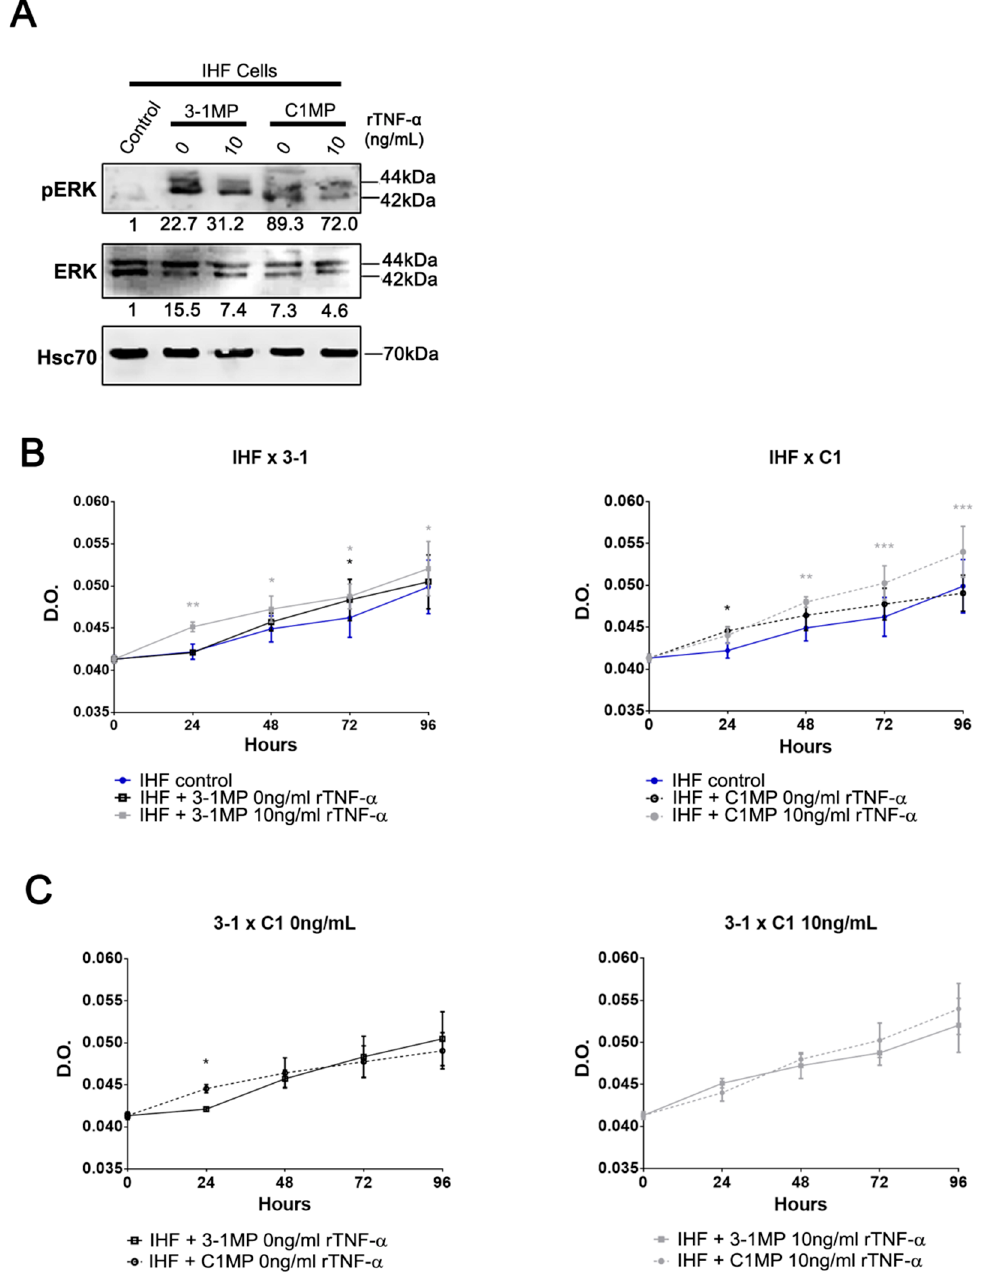
Figure 8. Proliferation rate of IHF cells after incubation with MP (microparticles) derived from parental and MDR cell lines. ( A ) Immunoblot analysis of ERK and phospho-ERK protein levels in IHF cells after incubation with MP derived from non-treated or 10 ng / mL rTNF- α treated KB-3-1 and KB-C1 cells. Western blot bands were quantified by densitometry. ( B , C ) Proliferation rate determined by crystal violet incorporation assay during 96 hour treatment with 3-1MP or C1MP derived from non-treated or 10ng / mL rTNF- α treated cells. Data are means ± SD of three independent experiments. Two-way ANOVA with Bonferroni posttest were used to analyze the crystal violet incorporation assay results. Black and gray asterisks represent statistical significance between MP derived from non-treated and rTNF- α -treated cells, respectively. * p < 0.05; ** p < 0.01; *** p < 0.005 indicate the statistical significance of data compared with non-treated cells or IHF incubated with 3-1MP.